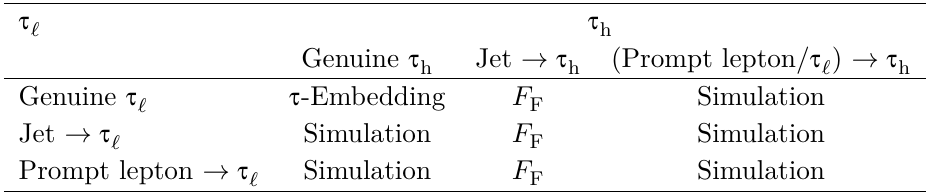
channel are shown in the rows and Table 4 . The different sources of backgrounds in the t ‘ t h columns. The entries in the table represent the possible t lepton pair background contribution from different processes and misidentifications and encapsulate the different experimental techniques that are deployed to estimate the background